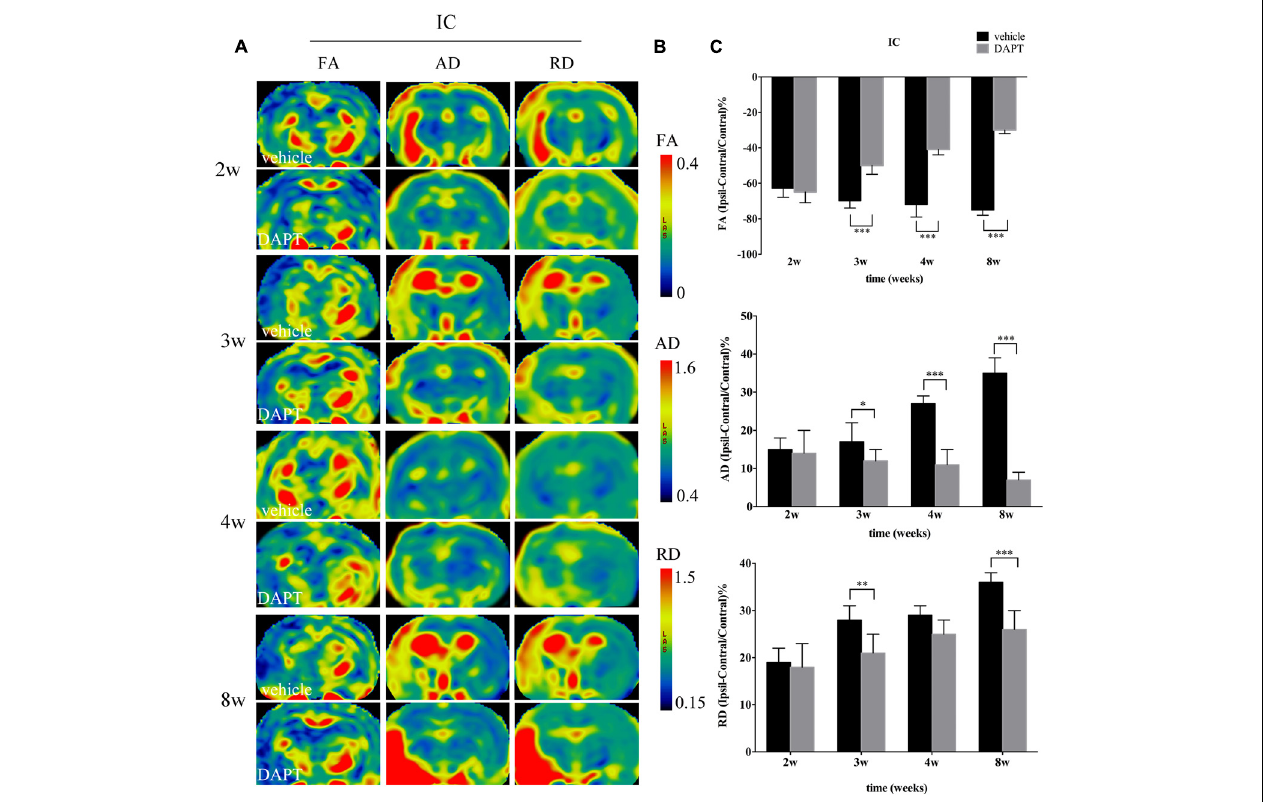
FIGURE 6 | Effects of DAPT on microstructure changes of internal capsule (IC) with DTI maps after MCAO. (A) The evolution changes in FA, AD and RD of ipsilateral IC in DAPT-treated rats and vehicle rats from 2 to 8w. (B) The range of FA, AD and RD. (C) Comparisons of FA, AD and RD of ipsilateral IC between two group rats. FA: ∗∗∗ P < 0.001, 3w, 4w, 8w versus DAPT and vehicle. AD: ∗ P < 0.05, 3w; ∗∗∗ P < 0.001, 4w, 8w versus DAPT and vehicle. RD: ∗∗ P < 0.01, 3w; ∗∗∗ P < 0.001, 8w versus DAPT and